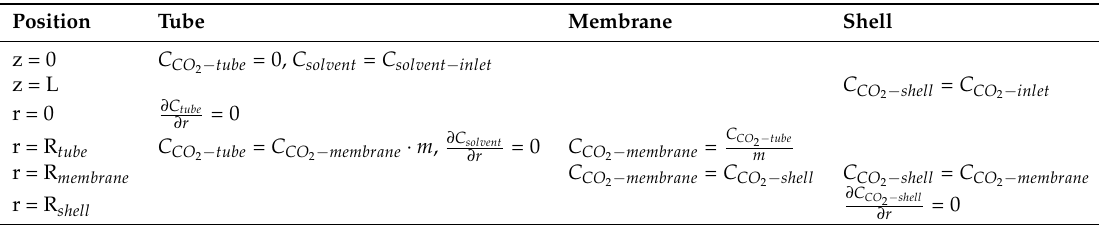
Table 3. Concentration boundary conditions in a 2D axisymmetric HFMC with solvent flowing into the tube side at z = L and flue gas flowing into the shell side at z = 0, as shown in Figure 7 [60]. Position Tube Membrane Shell z =